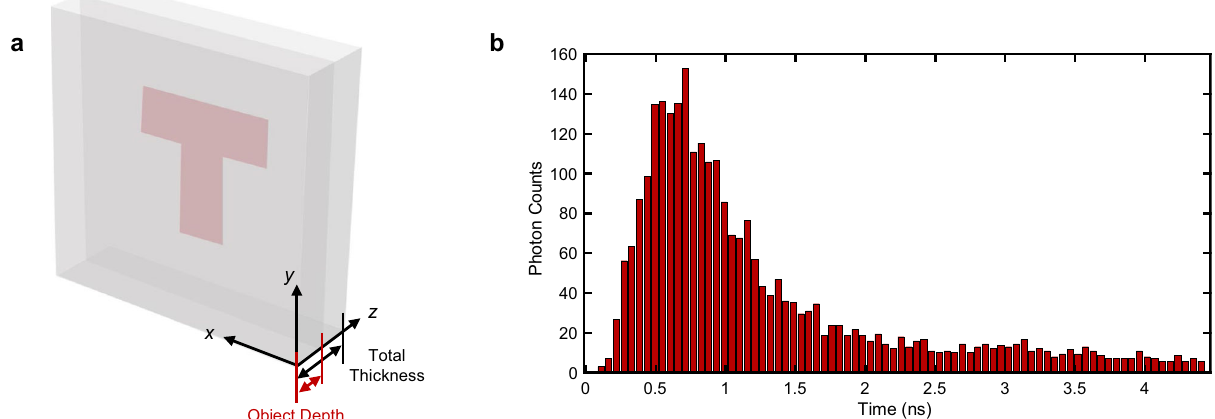
Fig. 3 Scenario layout and the temporal response in the polyethylene foam. a The scenario layout of the target and the polyethylene foam. Taking the target letter ‘ T ’ as an example, it is located at 8 cm in the foam and the total thickness of the foam is 15 cm. The object depth is de fi ned as the distance between the object and the front surface of the media. b The temporal response at one of the scanning points is captured by the ultrafast detector in the scenario shown in ( a ). Since the foam is an isotropic scattering medium where photon scatters at all angles with equal probability, the signal photons re fl ected by the target are highly coupled with background photons re fl ected by the scattering media.